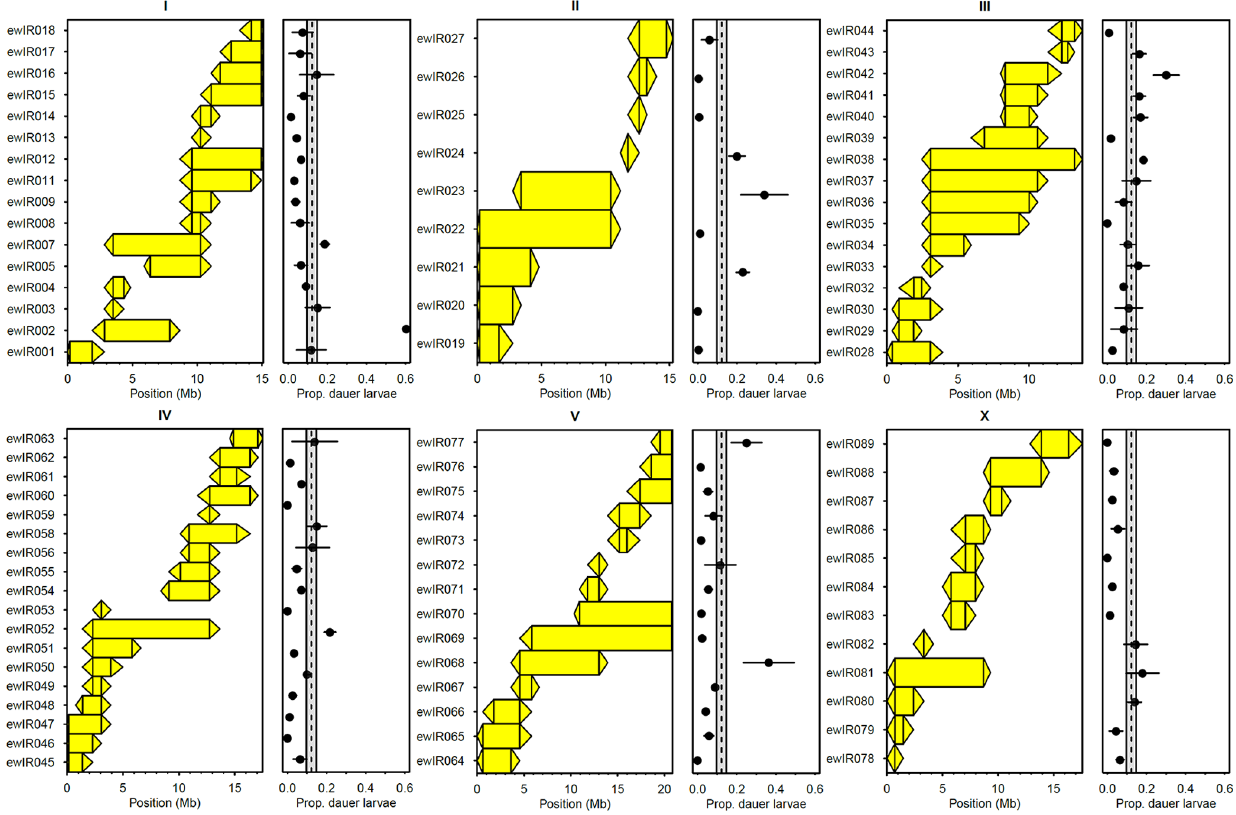
Figure 4. Introgression lines differ in dauer larvae formation in response to defined amounts of pheromone. Shown for each chromosome are the ILs assayed (left hand panels), with the CB4856 introgression per IL shown by the colored rectangle and triangles joining adjacent CB4856 and N2 markers, and the proportion of dauer larvae that developed in each IL (right hand panels) in dauer larvae formation assays with 25 m l of dauer pheromone extract and 20 m l of 1% w/v E. coli . Error bar represent 6 1 S.E. and the dashed lines and shaded bars represent